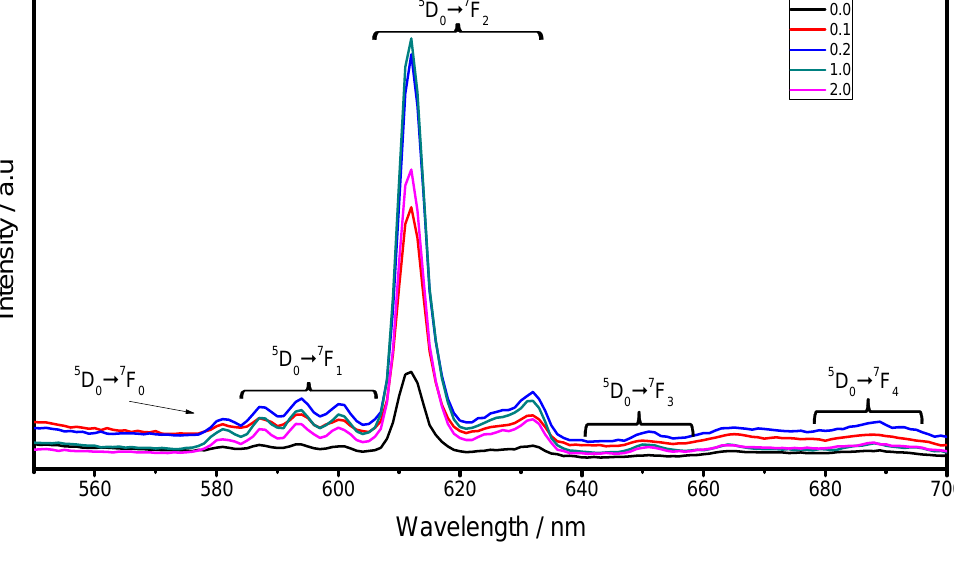
= 254 nm) of Lu O :Eu 3+ F127 modified thin films as a exc 2 3